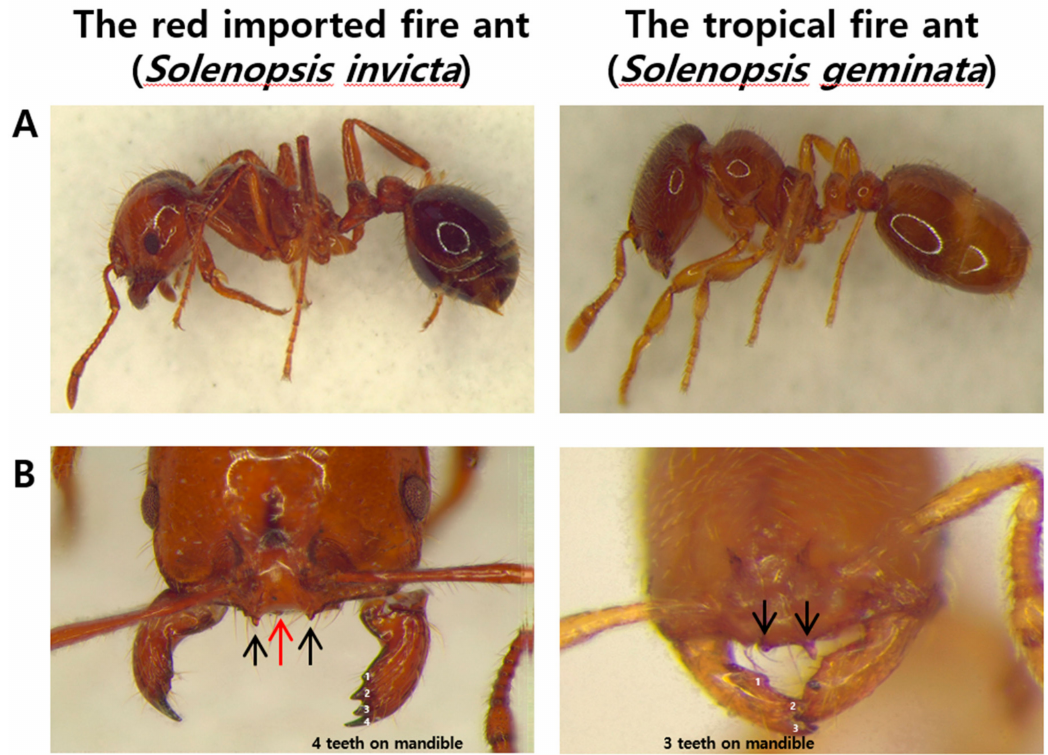
Figure 1. Morphological characteristics of two fire ants, Solenopsis invicta and S. geminata . ( A ): Body in lateral view. ( B ): Head in front view. Black arrows indicate clypeal teeth and the red arrow indicates a median clypeal tooth. Arabic numerals represent the number of teeth on the